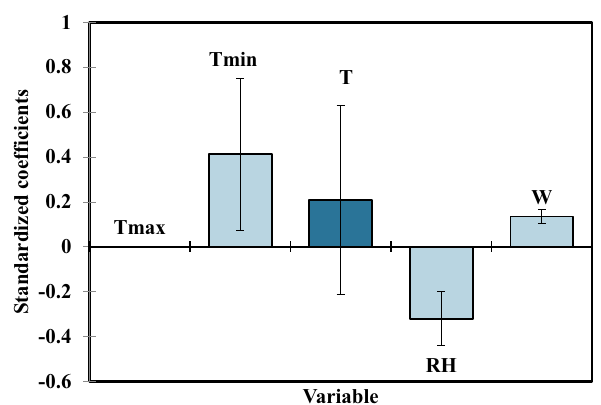
Fig. 4 The standardized coefficients of input variable for